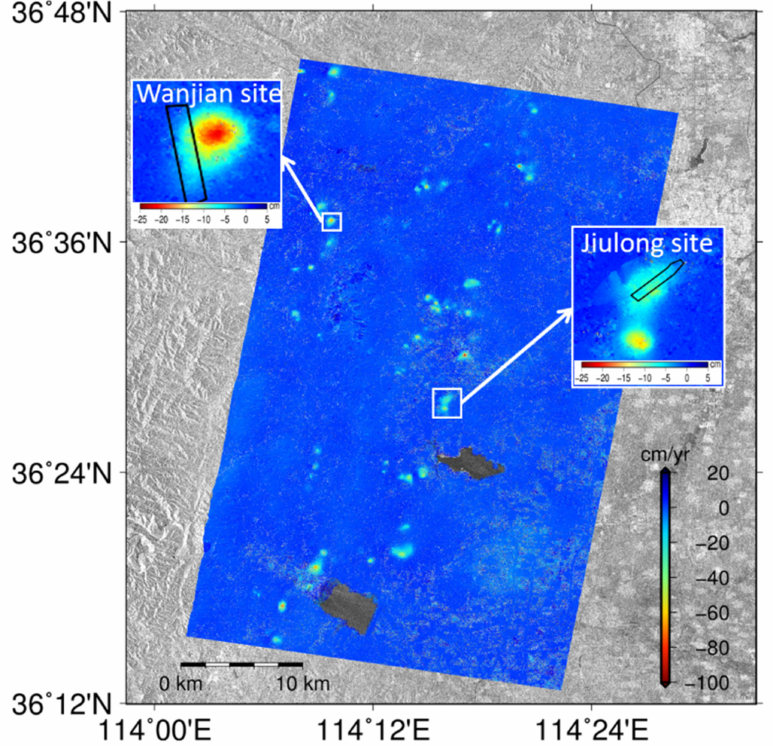
Figure 6. The deformation velocity between December 2015 and April 2016 was estimated with TerraSAR–X